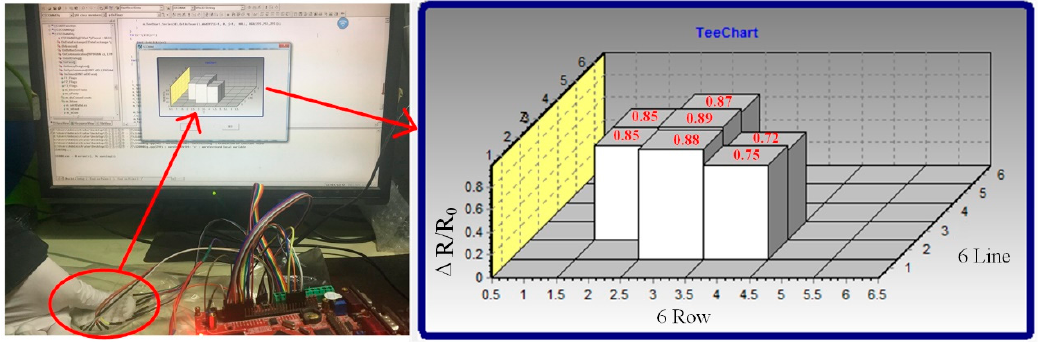
Figure 10. The test process (the red circle is the manually applied pressure on the array). It brings